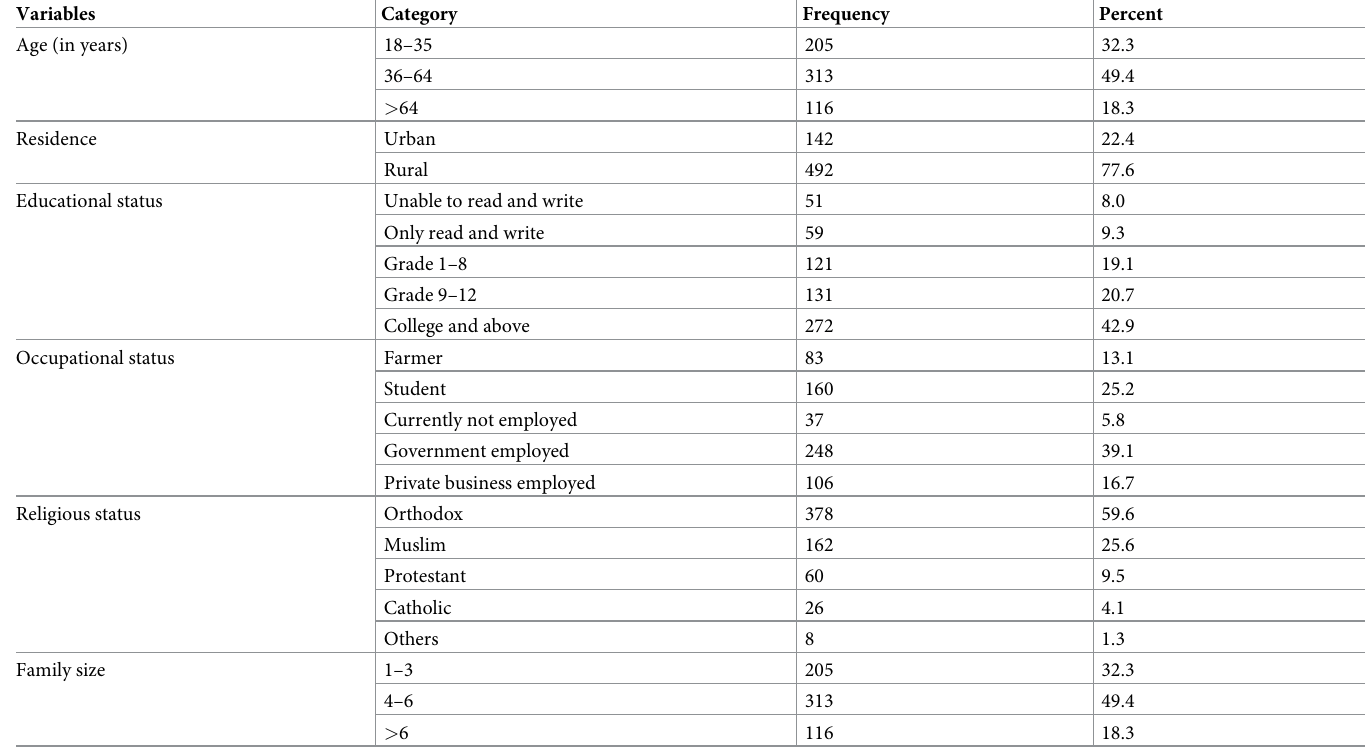
Table 1. The socio-demographic characteristics of residents in Guraghe Zone, 2020 (n = 634). Variables Category Age (in